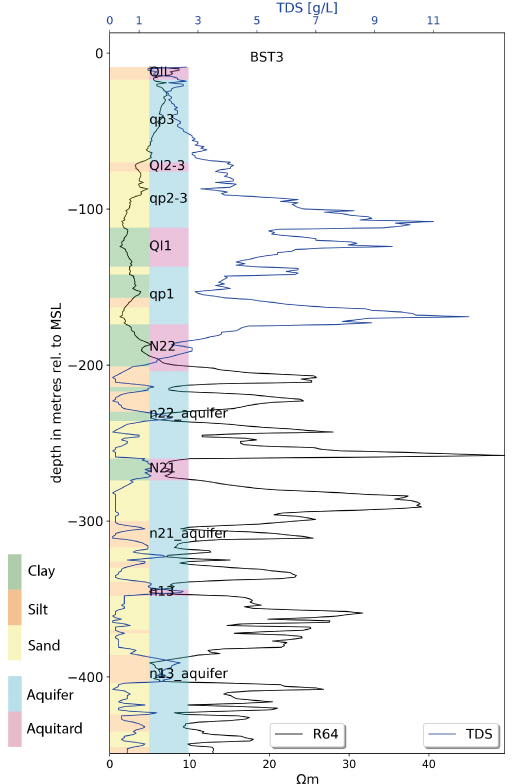
Figure 5. Typical geophysical logs (black line) and borehole de- scription, resulting in TDS concentrations (blue line).